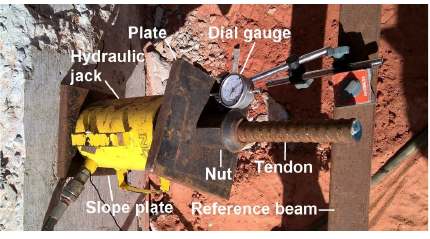
Figure 9 - Pullout test apparatus.